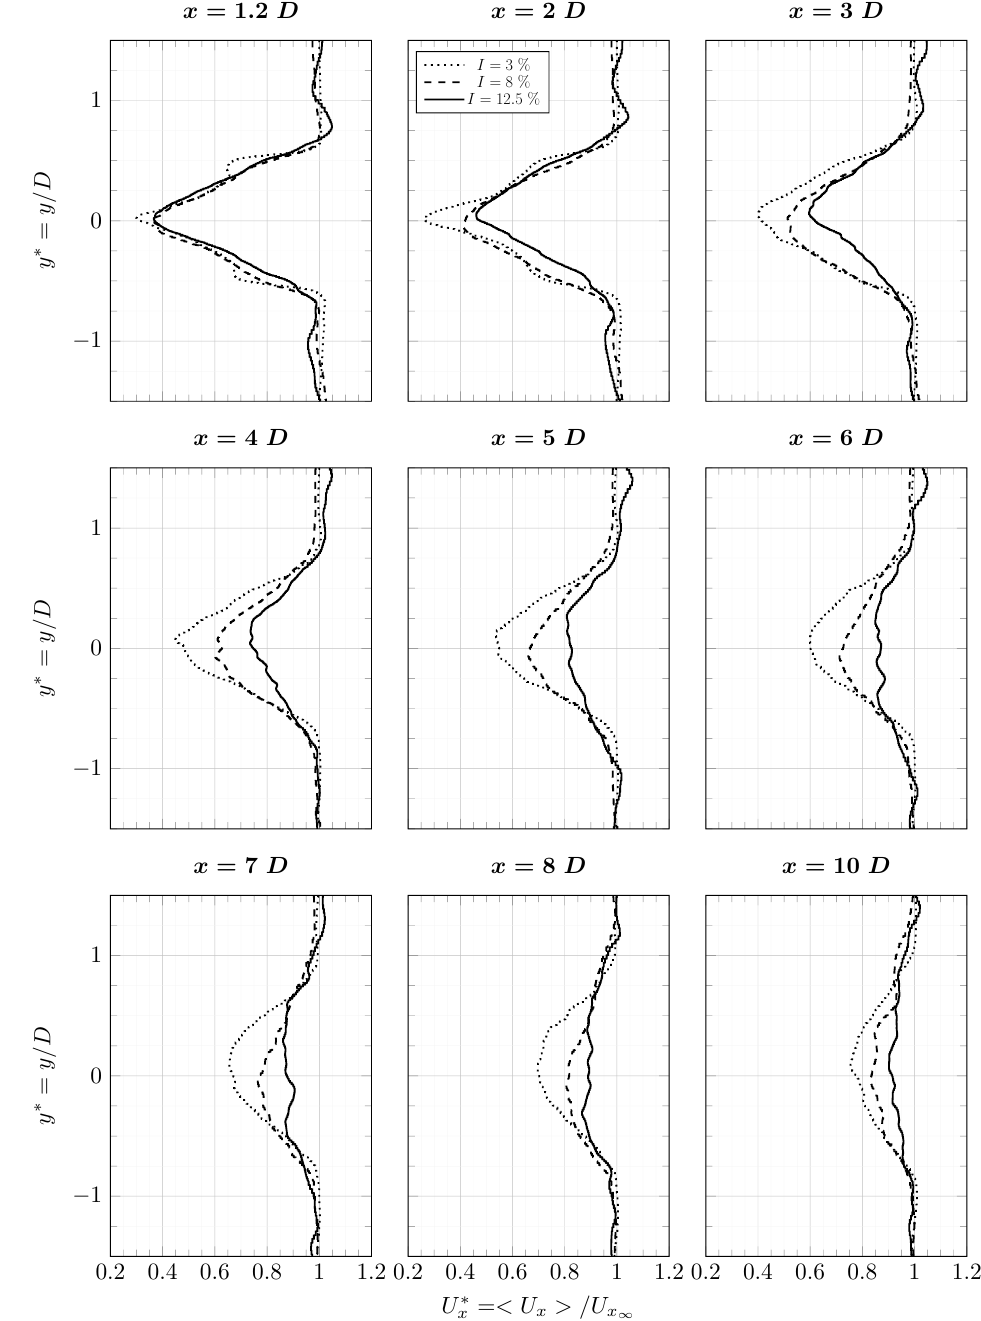
Figure 24. Average shear stress profiles < u (cid:48) x u (cid:48) y > in the wake of the tidal turbine simulated in LBM-LES at TSR = 3.67 with upstream turbulence intensities of I = [ 3,8,12.5 ] %. Table 7. Diameter of the wake of tidal turbine at TSR = 3.67 calculated from averaged axial velocity profiles from LBM-LES simulations with upstream turbulence intensities of I = [ 3,8,12.5 ] %. Upstream Diameter at Diameter at Diameter at Difference Difference Difference Turbulence x = 4 D x = 5 D x = 7 D 3% 1.23 m \ 1.33 m \ 1.50 m \ 8% 1.57 m + 28% 1.61 m + 21% 2.07 m + 38% 12.5% 1.54 m − 2% 2.13 m + 32% 2.41 m +